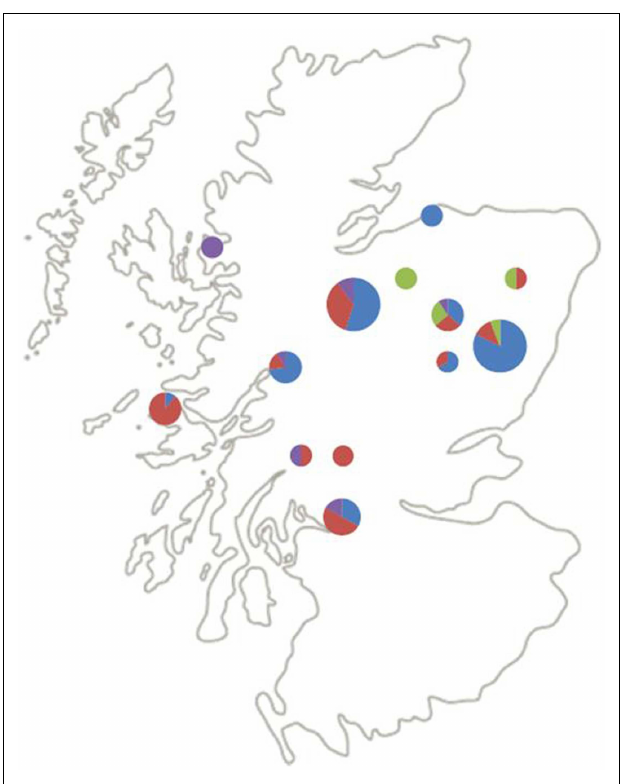
genospecies across Scotland . Blue = B. afzelii , red = B. garinii , purple = B. valaisiana , green = B. burgdorferi s.s.The size of the pie charts indicates the number of samples genotyped at that site (1–5, 6–10, and 11–20 samples for small, medium, and large pie charts,